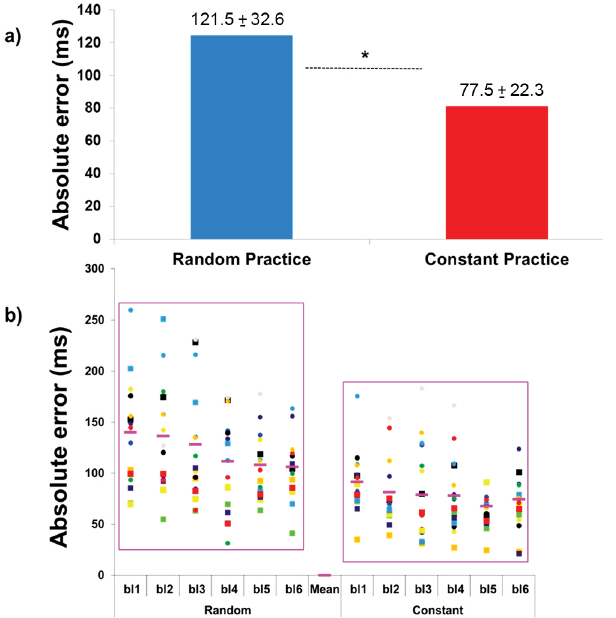
Figure 2. Absolute error: ( a ) means of the absolute error in the random and constant practice conditions, and ( b ) inter-subject variability over the blocks of trials (bl1 … bl6) during both random and constant practice conditions ( * represents significant